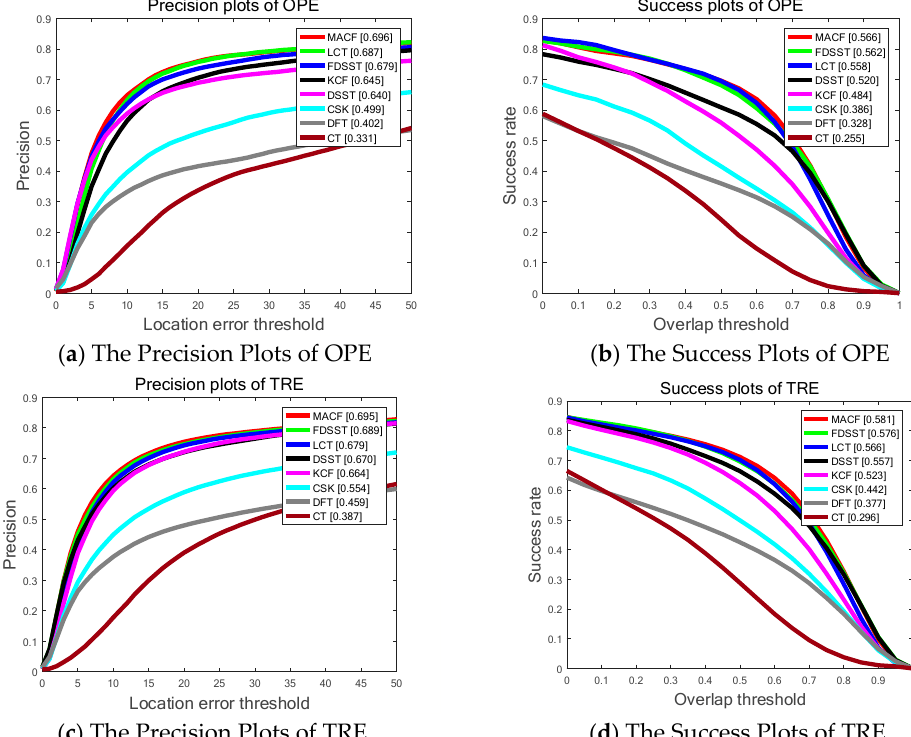
( c ) The Precision Plots of TRE ( d ) The Success Plots of TRE Figure 7. Cont